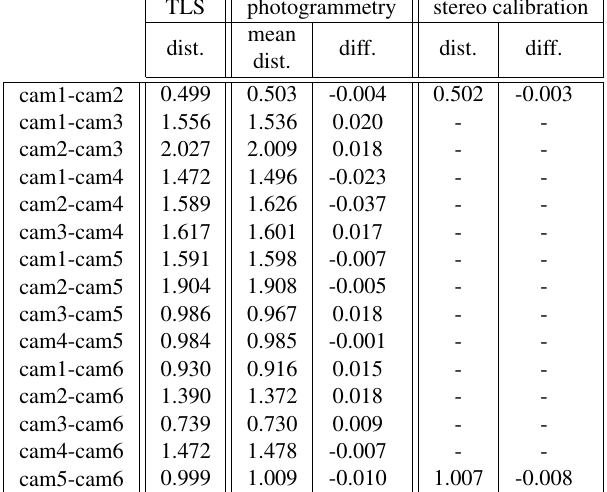
Table 2. Distances between cameras (in m ) obtained from lever-arm estimation, photogrammetry and optical calibration. Differences (in m ) between TLS distance and the two other computation methods are also given. Figure 9. Diagram of sonar point cloud process. Notations are introduced in Tab. 1.